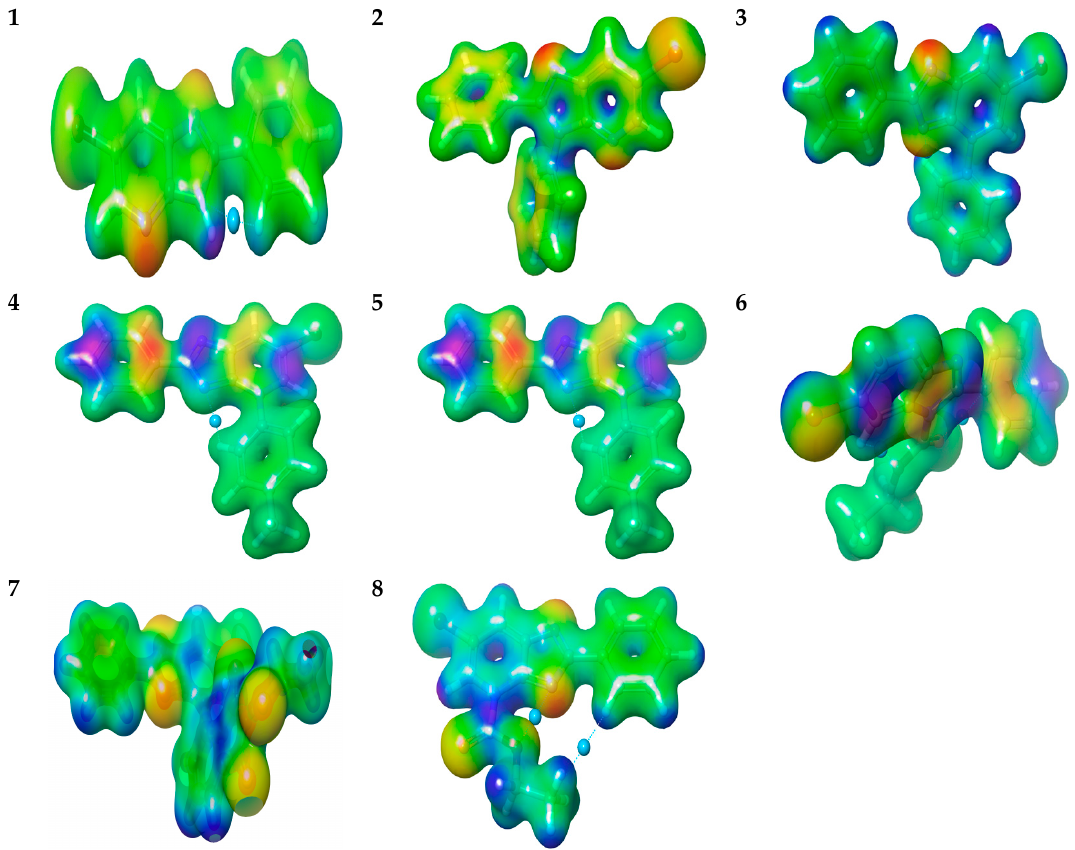
Figure 9. Molecular electrostatic potential map (0.032 contour value) and intramolecular noncovalent interactions for ( 1 – 8 ).